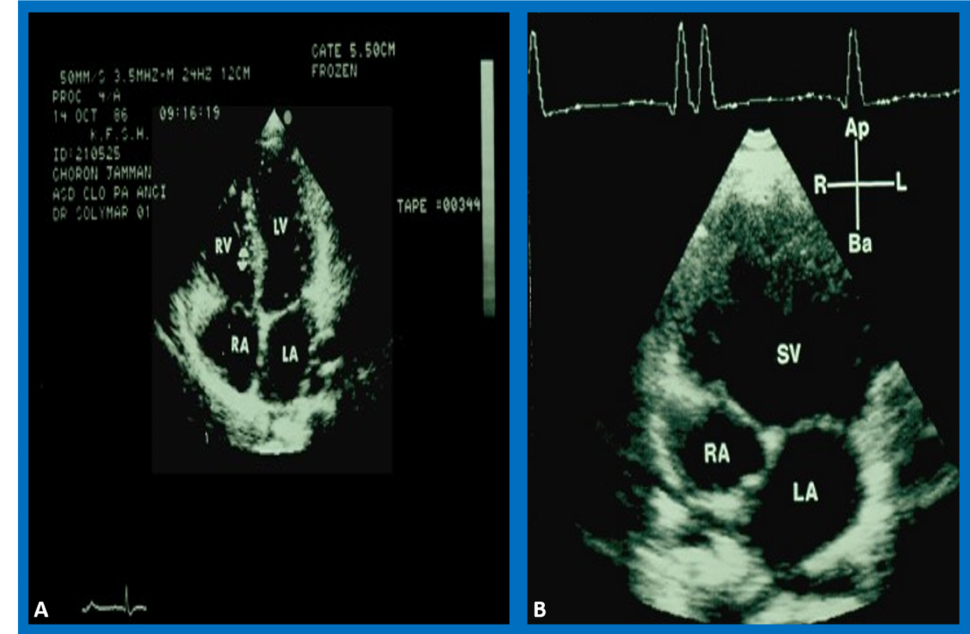
Figure 1. Selected video frames from two different patients. ( A ) shows the ventricular septum between the ventricles in a normal child while ( B ) demonstrates the absence of the ventricular septum. The figures show top-to-bottom reversal; this is because these figures were prepared prior to the American Society of Echocardiography recommendation of the current way in which we display the images. Left atrium (LA), left ventricle (LV), right atrium (RA), right ventricle (RV), and single ventricle (SV) are labeled.